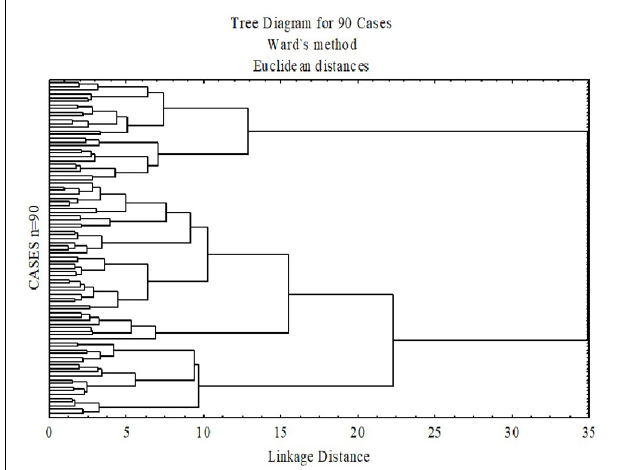
FIGURE 1 | Dendrogram based on Wald’s minimum-variance hierarchical clustering method. The 90 participants were clustered into a single final group. At each generation of clusters, samples were merged into larger clusters to minimize the within cluster sum of